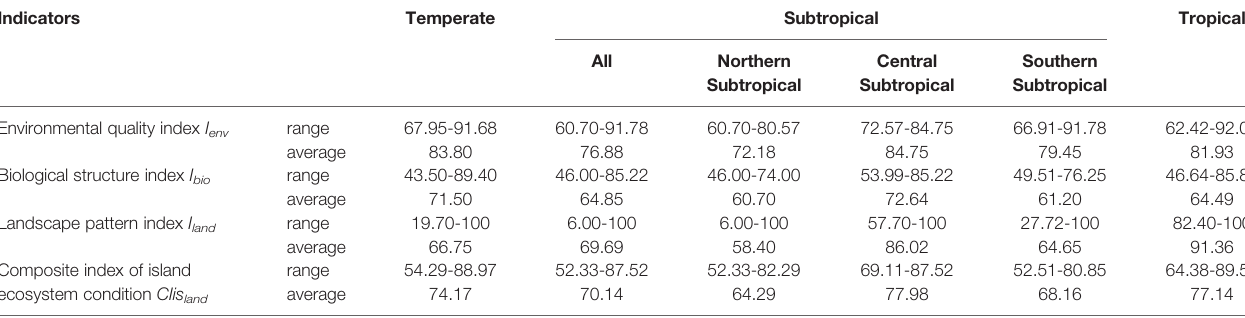
TABLE 7 | Integrated assessment scores of island conditions.